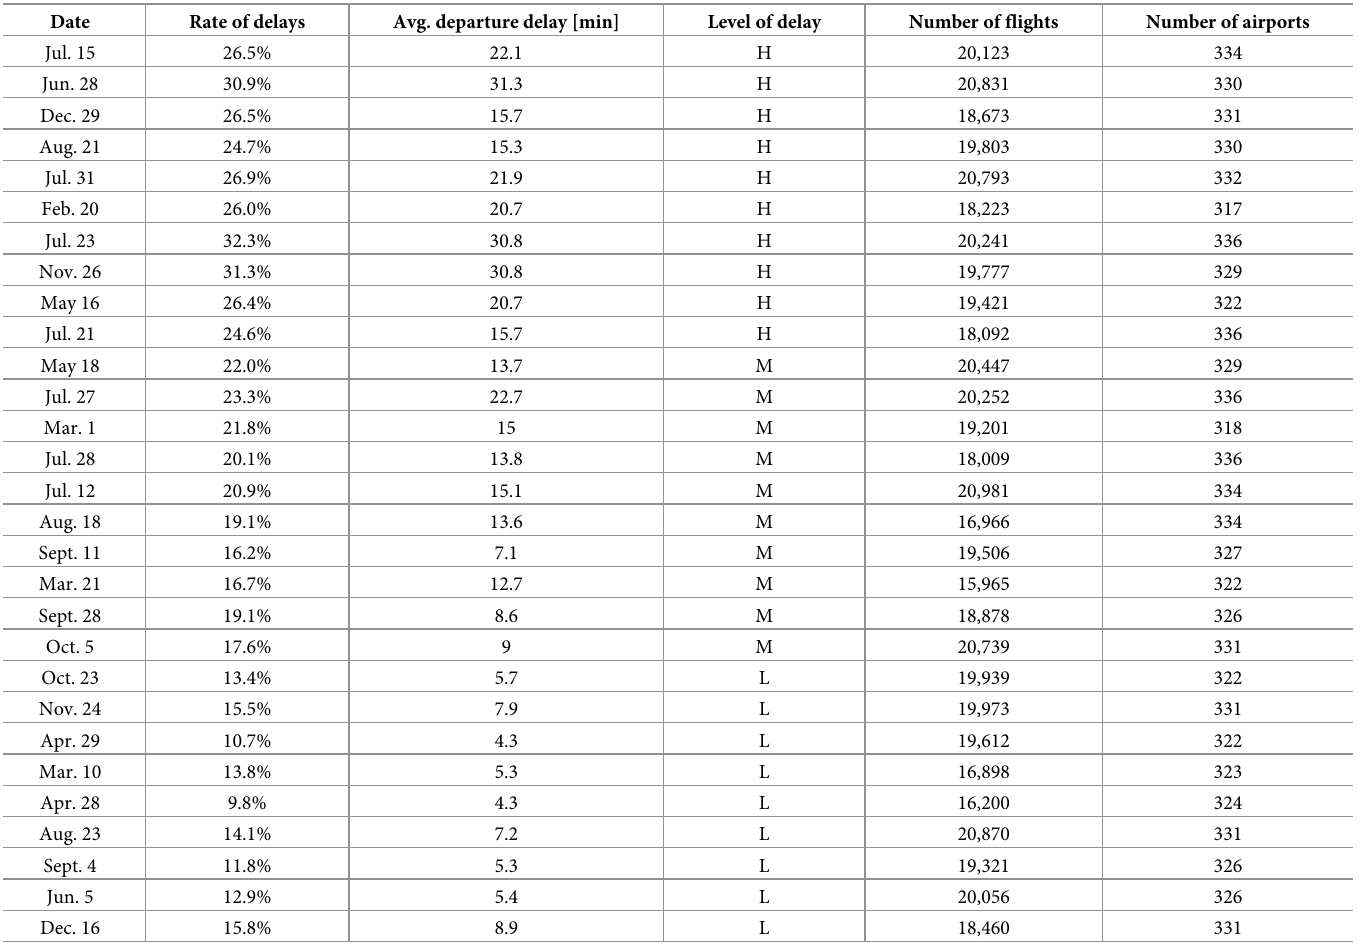
Table 2. Flight information and delay levels on test